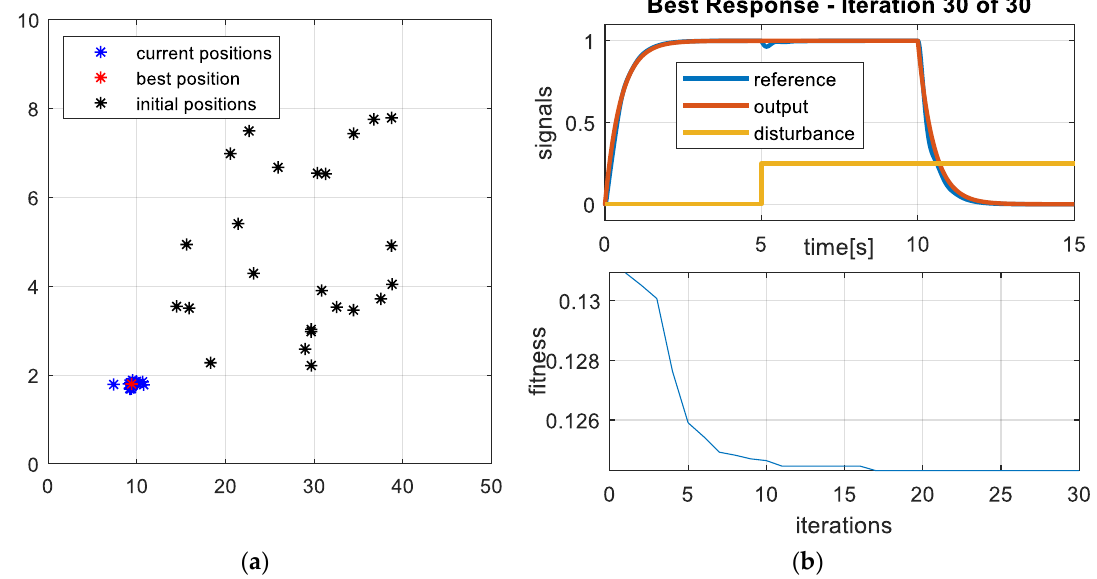
Figure 11. Best switching strategy as per the power available. ( a ) Best position for feeding the load; ( b ) Best response of the